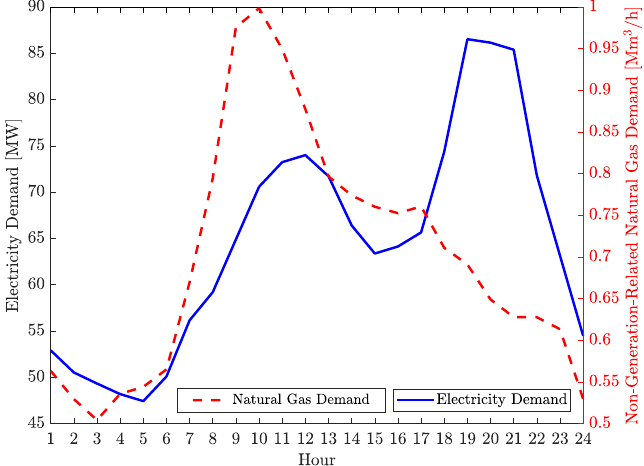
Figure 2. Example: non-generation-related gas demand and power demand.